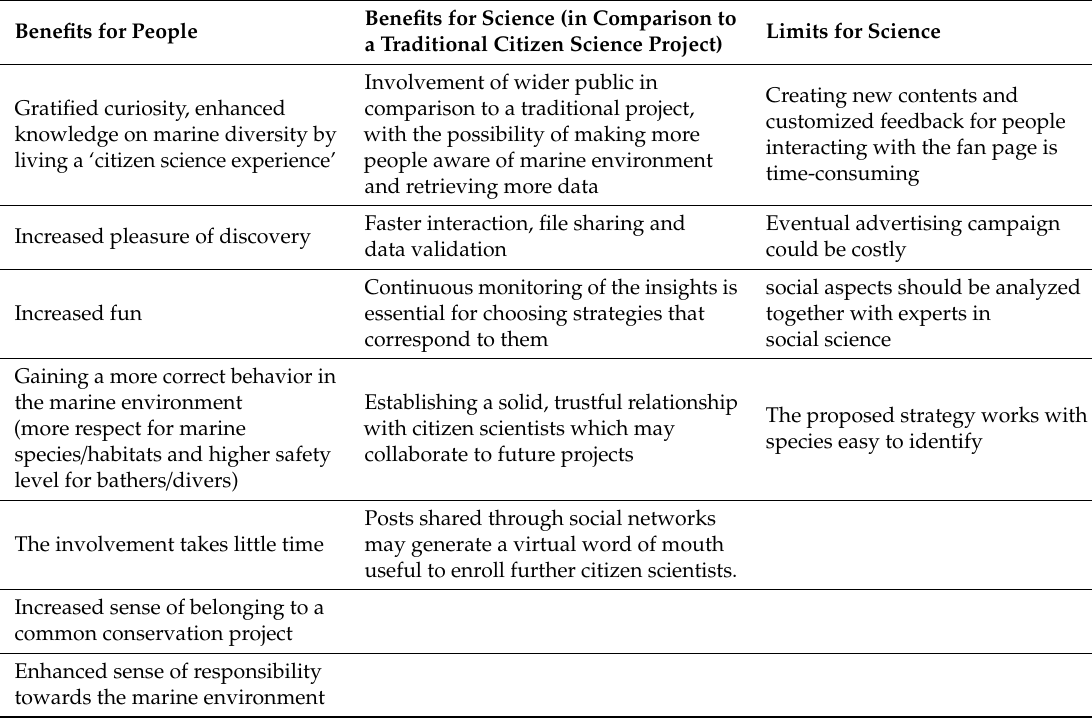
Table 1. Pro and cons of citizen science through social